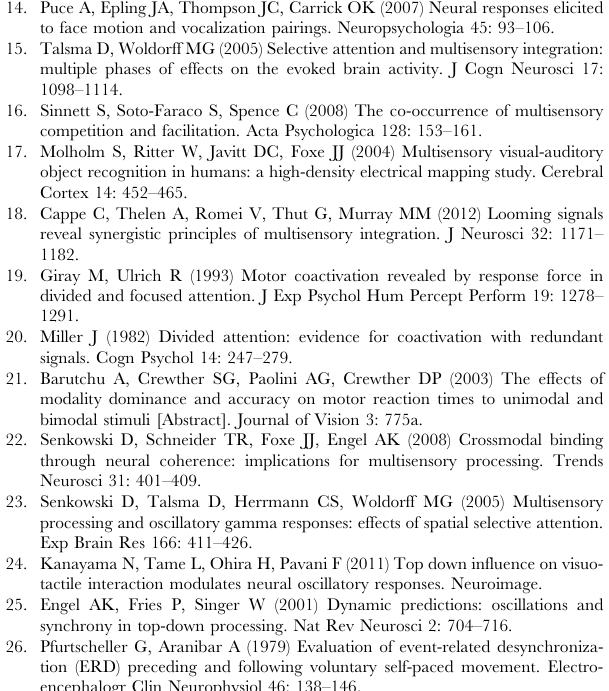
stimuli AIVI (auditory irrelevant and visual irrelevant), and the sum of its unisensory components AI (auditory irrelevant) and VI (visual irrelevant) (AI + VI) for occipital (O1 and O2) and parietal (P3 and P4) electrodes. B . Plot of significantly different t-tests for each time sample and channel where the AIVI and (AI + VI) ERPs significantly differ for 12 consecutive samples. Shaded regions depicting where the AIVI is significantly different from AI + VI. White regions p . .05, grey regions p , .05 and black regions p , .01. (TIF) Figure S2 Event-related potentials (ERPs) for target audiovisual stimuli. A . ERPs for the audiovisual stimuli ATVT (auditory target and visual target), and the sum of its unisensory components AT (auditory target) and VT (visual target) (AT + VT) for occipital (O1 and O2) and parietal (P3 and P4) electrodes. B . Plot of significantly different t-tests for each time sample and channel where the ATVT and (AT + VT) ERPs significantly differ for 12 consecutive samples. Shaded regions depicting where the ATVT ERP is significantly different from the AT + VT ERP. White regions p . .05, grey regions p , .05 and black regions p , .01. (TIF) Text S1 Subtracting audiovisual integration from target and irrelevant stimuli. Audiovisual integration as assessed using the subtraction method for irrelevant [MSI = AI- VI 2 (AI + VI)] and target stimuli [MSI =ATVT 2 (AT +